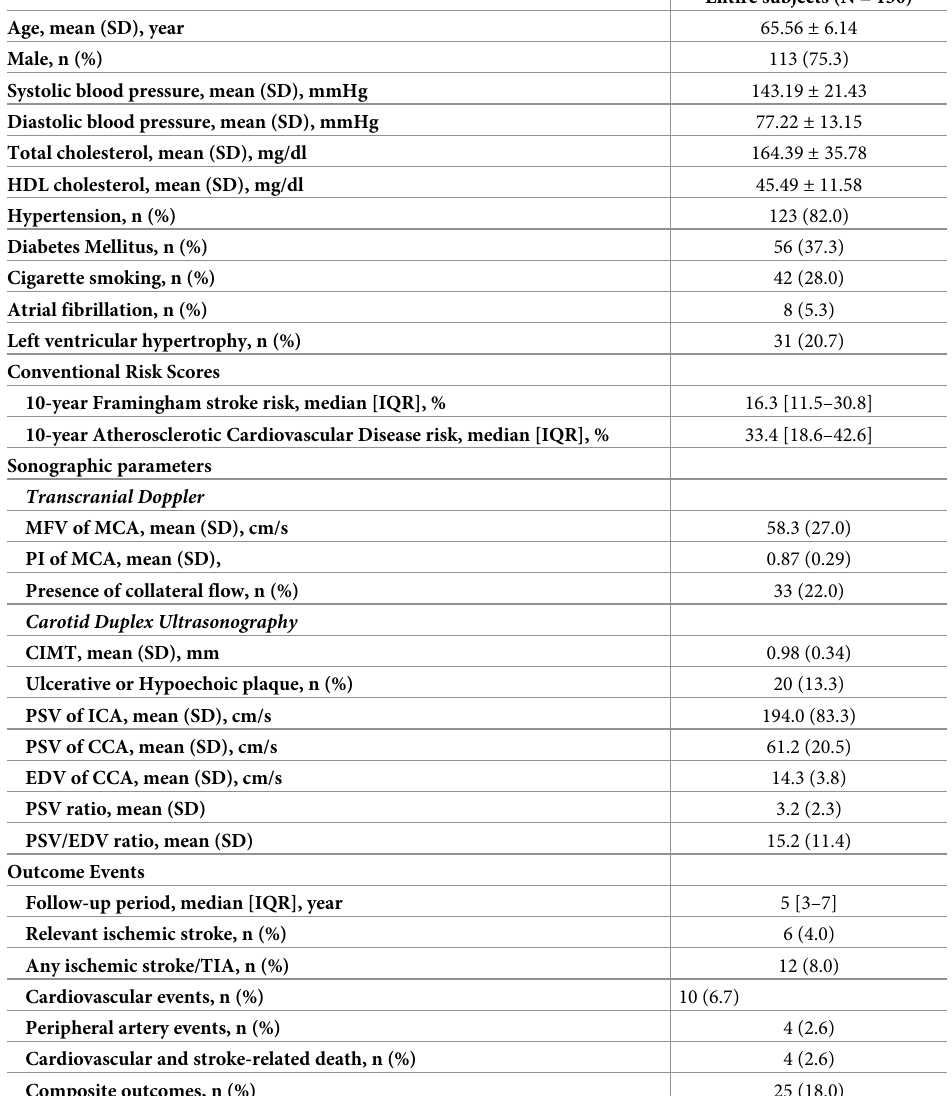
Table 1. Baseline characteristics of included